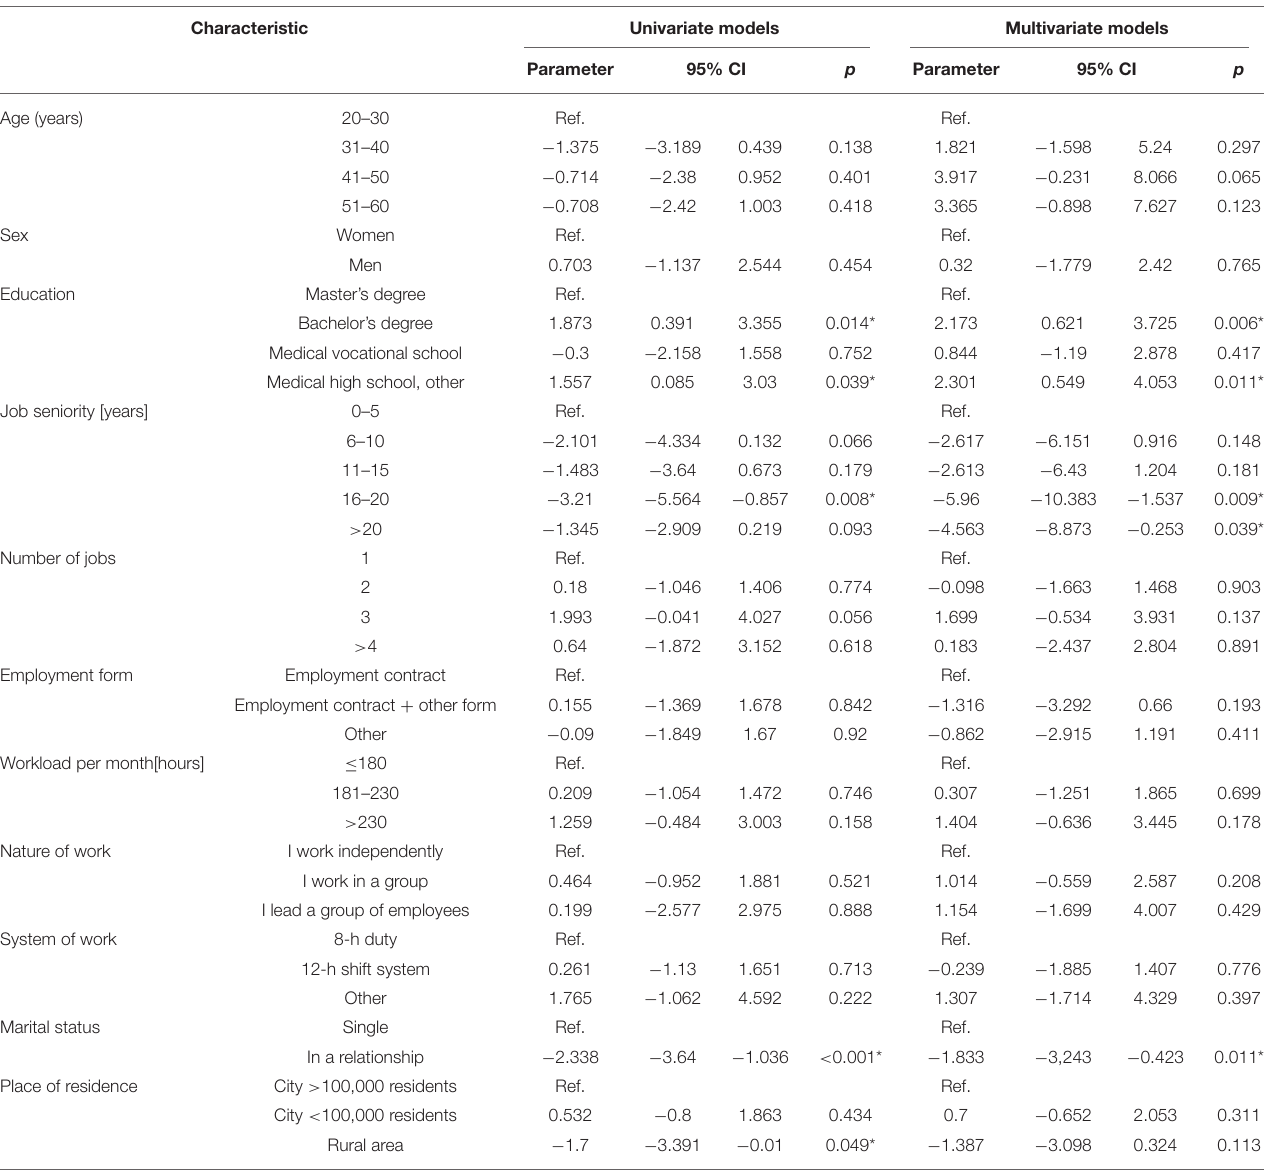
TABLE 3 | Univariate and multivariate analyses for